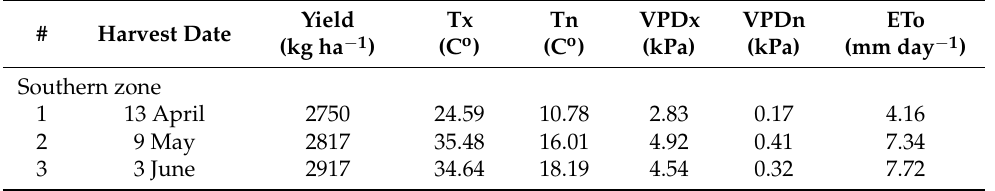
Table 1. Growth cycles’ yield and the mean climate parameters for each cycle in each management zone. The yield from the last cycle in the Northern zone was not